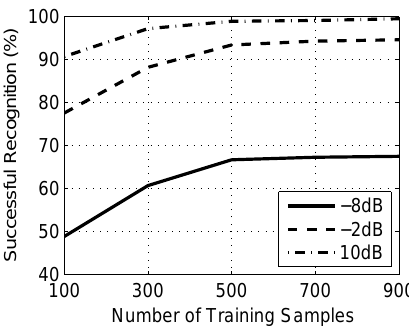
Figure 9. In this figure, successful recognition is measured by a different number of training